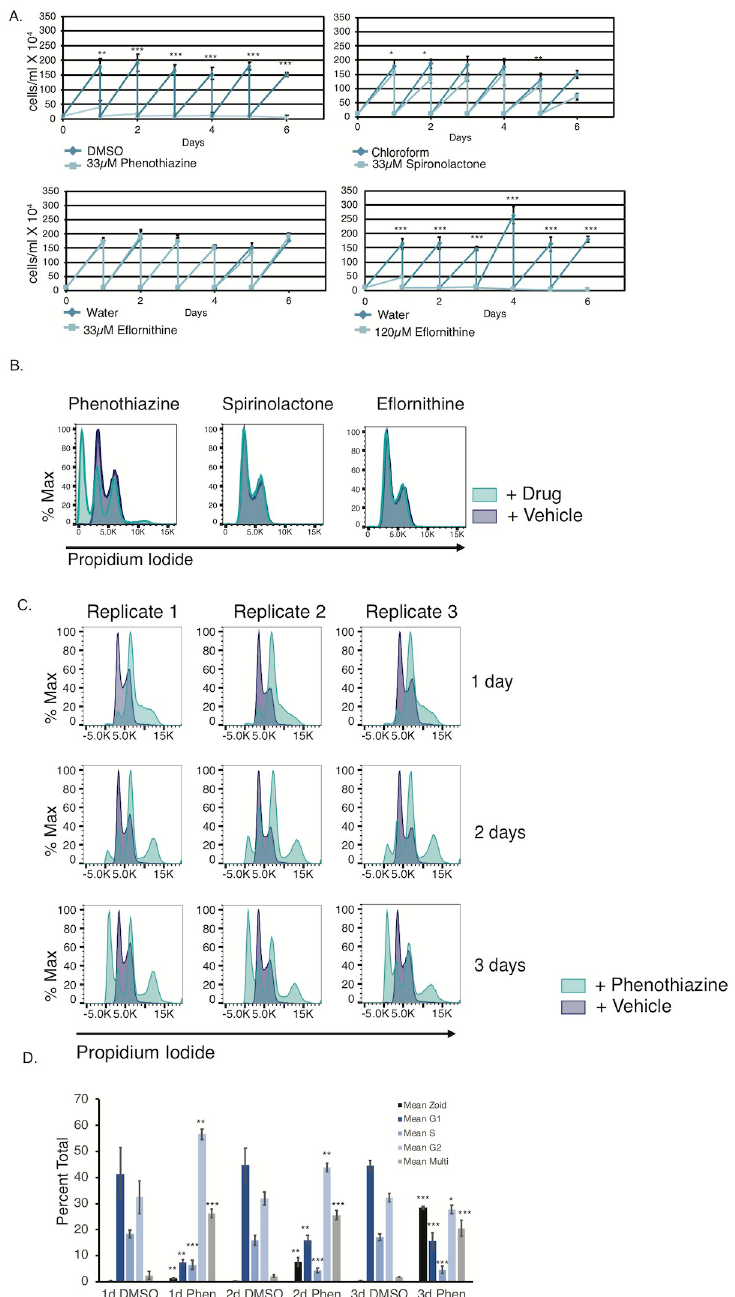
Fig 4. Phenothiazine-treated parasites are growth-arrested and show cell cycle defects. (A) Growth curves of bloodstream parasites grown in the presence of the indicated drug or vehicle control for 6 days. Parasites were counted daily on a hemacytometer and diluted to 100,000 cells/ml after counting. Error bars indicate standard deviation of 3 biological replicates. � , �� , ��� indicates p < 0.05, p < 0.01, and p < 0.001 respectively as measured by an unpaired two- sided Student’s t-test. (B) Flow cytometry plot using propidium iodide staining to assay cell cycle in bloodstream parasites treated with the 33 μ M of the indicated drug or vehicle control for 3 days. (C) Flow cytometry plot using propidium iodide staining to assay cell cycle in bloodstream parasites treated with the 33 μ M phenothiazine or vehicle control for the indicated number of days. (D) Quantification of the data collected in (C) showing the percent of cells in each phase of the cell cycle. � , �� , ��� indicates p < 0.05, p < 0.01, and p < 0.001 respectively as measured by an unpaired two-sided Student’s